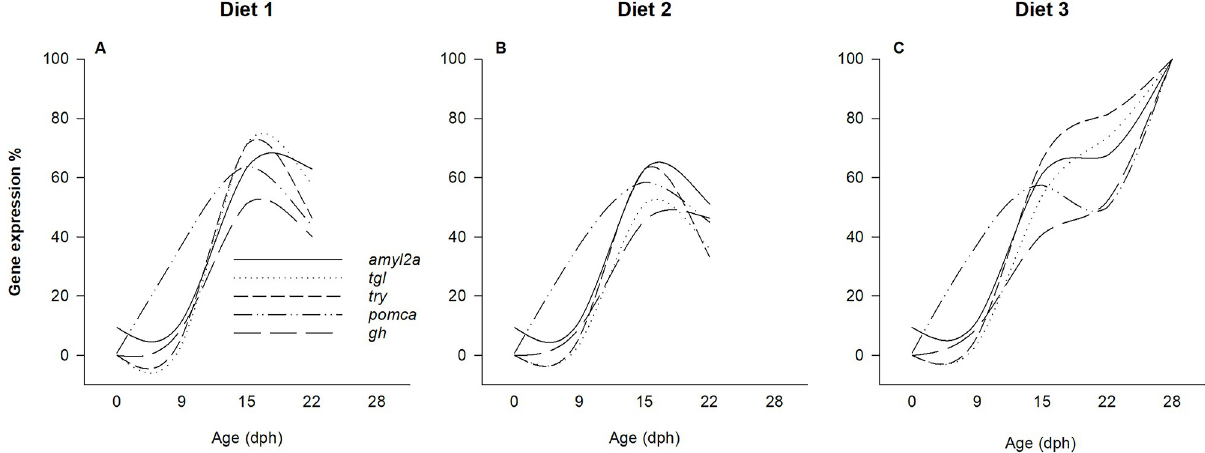
Fig 8. Relative expression of selected genes. Overview, showcasing the difference in expression of selected genes standardized to the highest recorded transcript of that gene ( try , amyl2a , tgl , pomca and gh ) in European eel, Anguilla anguilla , larvae fed diet 1 (A), diet 2 (B) and diet 3 (C) throughout the experimental period (from 0 to 28 days post hatch